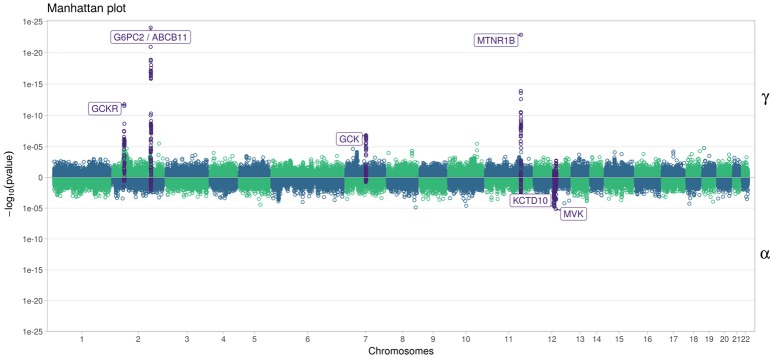
Manhattan plot for estimated effects of γ and α using “JM” (Rizopoulos, 2010, 2017). Results are presented for the cleaned set of 101,305 SNPs.